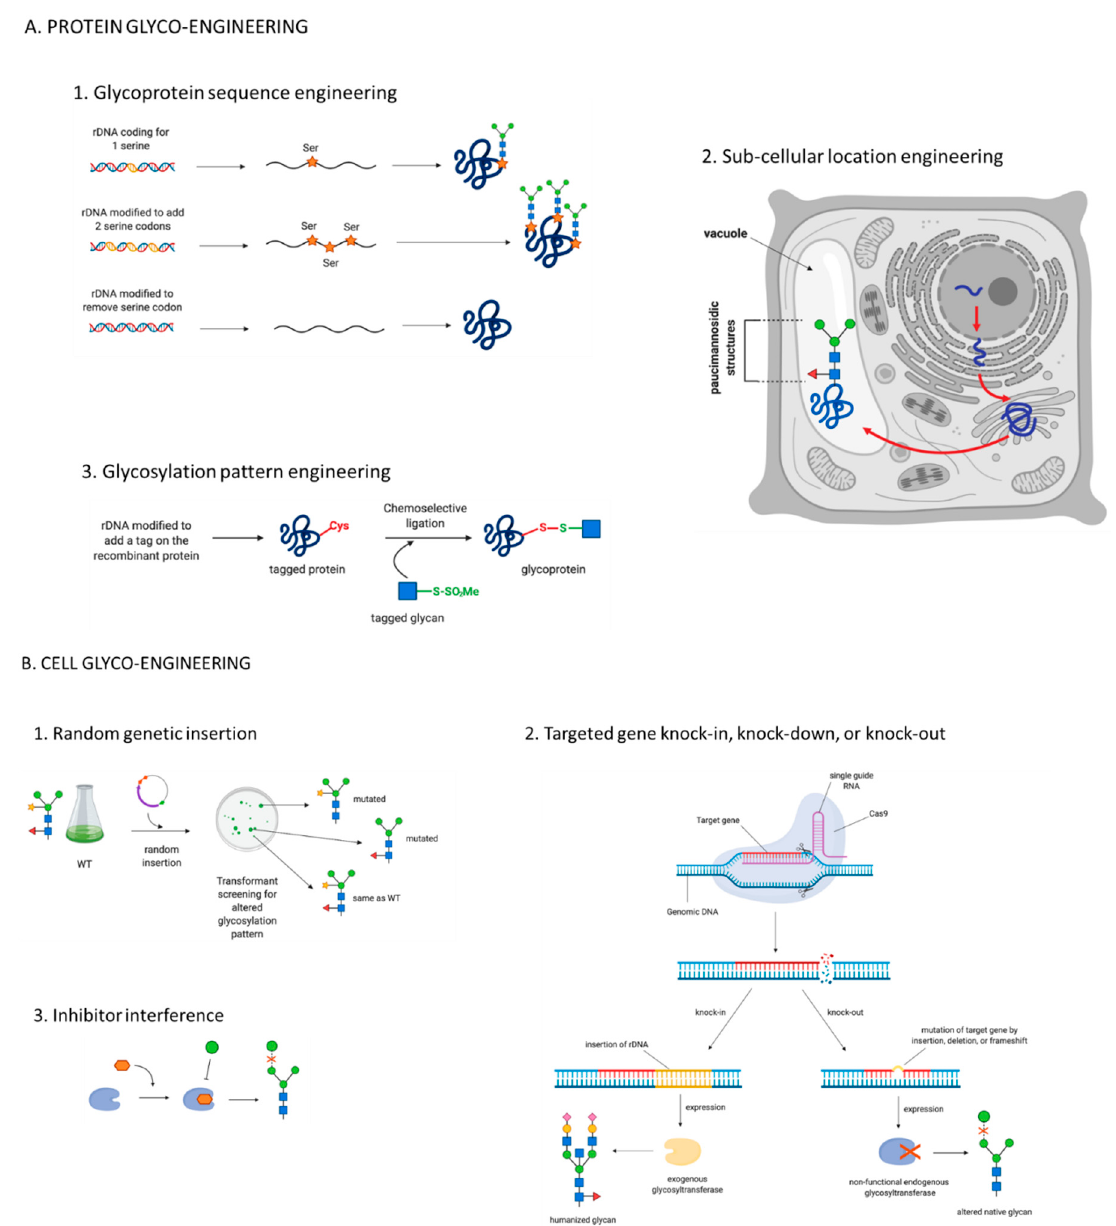
Figure 4. A schematic of di ff erent glyco-engineering strategies; ( A ) protein engineering and ( B ) cell engineering. Protein glyco-engineering approaches ( A ) can target (1) the recombinant DNA sequence (rDNA) [137], (2) the sub-cellular location of the biopharmaceutical [112], and (3) the glycosylation pattern of the translated protein [138,139]. Cell glyco-engineering strategies ( B ) can modify the activity of glycosylation enzymes by (1) random genetic insertion [140], (2) targeted gene knock-in or knock-out [141–145], and (3) inhibitor interference [138]. Green circle = Mannose. Blue circle = Glucose. Yellow circle = Galactose. Blue square = GlcNAc. Fuchsia diamond = Sialic acid. Yellow star = Xylose. Red triangle =